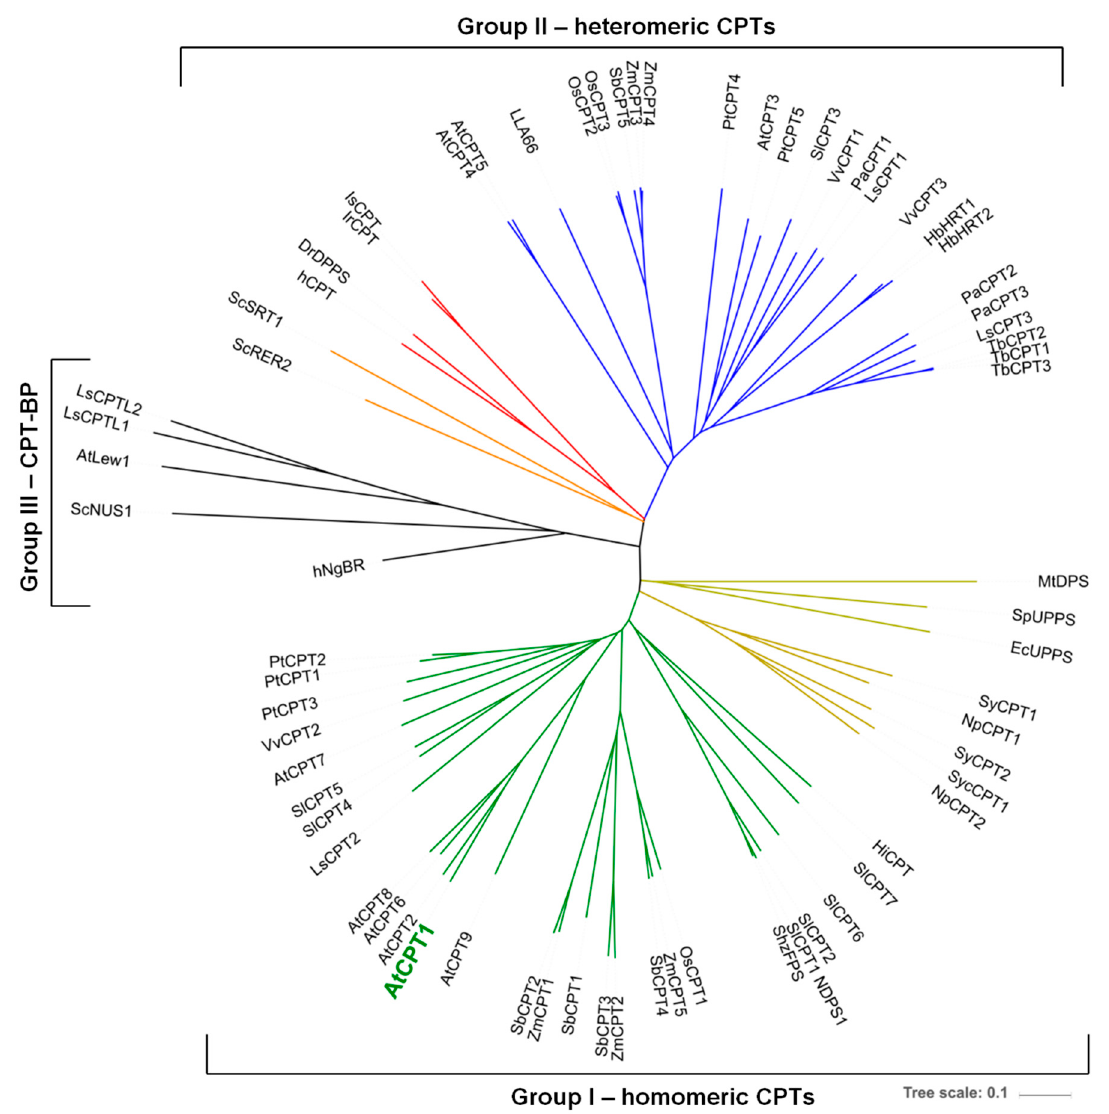
Figure 6. Phylogenetic analysis of CPTs. Neighbor-joining phylogenetic tree of CPTs and CPT related protein from plants (green or blue branches), animals (red), yeast (orange) and bacteria (yellow). The analyzed proteins sequences are divided into three groups: (I) the homomeric CPTs, (II) heteromeric CTPs that form a complex with a CPT-binding protein and (III) CPT-binding protein including the human NogoB receptor and its orthologs. Amino acid sequences were aligned using http://www.phylogeny.fr/index.cgi and the tree was constructed using https://itol.embl.de/. Species abbreviations: At, Arabidopsis thaliana ; Dr, Danio rerio ; Ec, Escherichia coli ; Hb, Hevea brasiliensis ; h, Homo sapiens ; Hi, Handroanthus impetiginosus ; Ir, Ixodes ricinus ; Is, Ixodes scapularis ; LL, Lilium longiflorum ; Ls, Lactuca sativa ; Mt, Mycobacterium tuberculosis ; Np, Nostoc punctiforme ; Os, Oryza sativa ; Pa, Parthenium argentatum ; Pt, Populus trichocarpa ; Sb, Sorghum bicolour ; Sc, Saccharomyces cerevisiae ; Shz, Solanum habrochaites ; Sl, Solanum lycopersicum ; Sp, Streptococcus pneumoniae ; Sy, Synechococcus; Syc, Synechocystis; Tb, Taraxacum brevicorniculatum ; Vv, Vitis vinifera ; Zm, Zea mays.